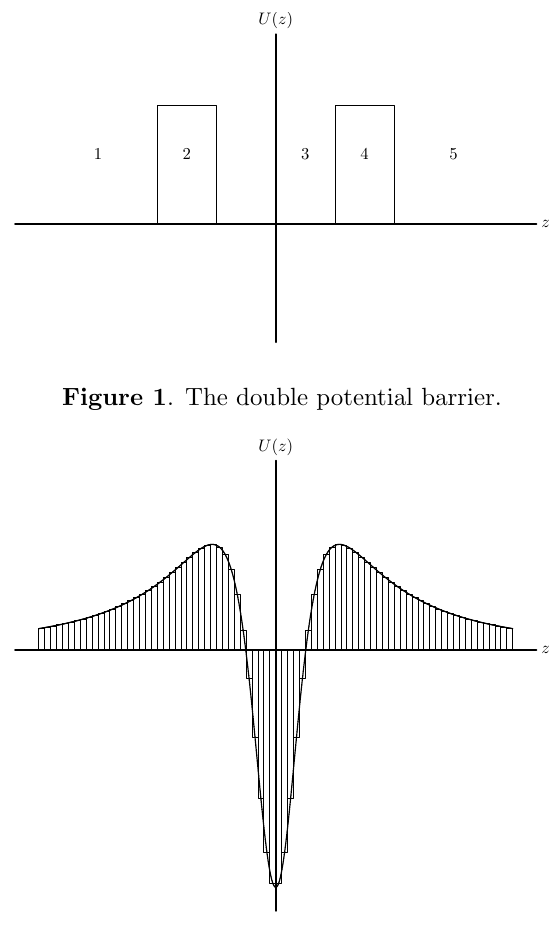
Figure 2 . Potential approximation by